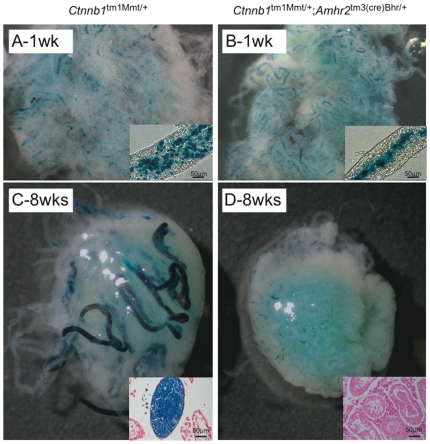

Ctnnb1
tm1Mmt/+;Amhr2
tm3(cre)Bhr/+ testes are unable to support donor SSCs.(A, B) Photographs of decapsulated, LacZ-stained recipient Ctnnb1tm1Mmt/+ (A) or Ctnnb1
tm1Mmt/+;Amhr2
tm3(cre)Bhr/+ (B) testes 1 week after transplantation of Gt(ROSA)26Sor germ cells. Insets show higher magnification lateral views of seminiferous tubules from the corresponding testes. (C, D) Photographs of decapsulated, LacZ-stained recipient Ctnnb1tm1Mmt/+ (C) or Ctnnb1
tm1Mmt/+;Amhr2
tm3(cre)Bhr/+ (D) testes 8 weeks after transplantation of Gt(ROSA)26Sor germ cells. Insets are photomicrographs demonstrating complete regeneration of spermatogenesis in the Ctnnb1tm1Mmt/+ testes (C), whereas no evidence for spermatogenesis was detected in the Ctnnb1
tm1Mmt/+;Amhr2
tm3(cre)Bhr/+ testes (D). Original magnification 32× (A, B) or 16× (C, D).